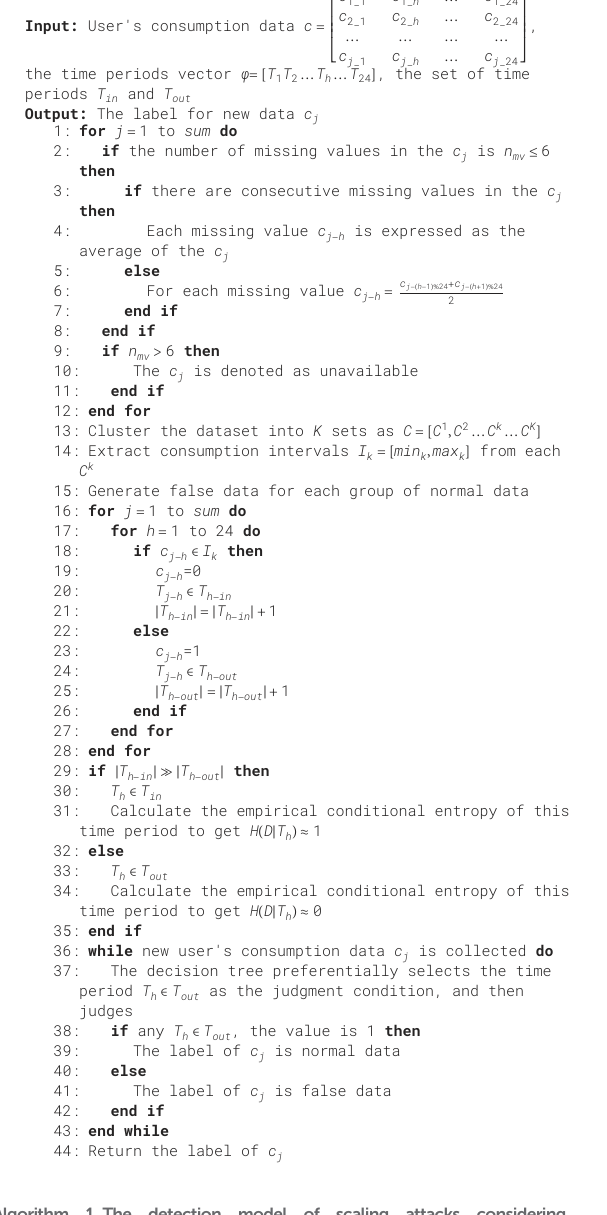
Algorithm 1. The detection model of scaling attacks considering consumptionpatterndiversityinAMI( SA2CPD